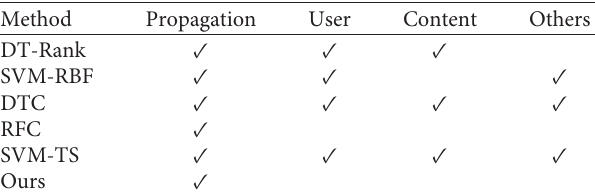
Table 4: Performance of proposed propagation pattern model (R: rumor; N: nonrumor).